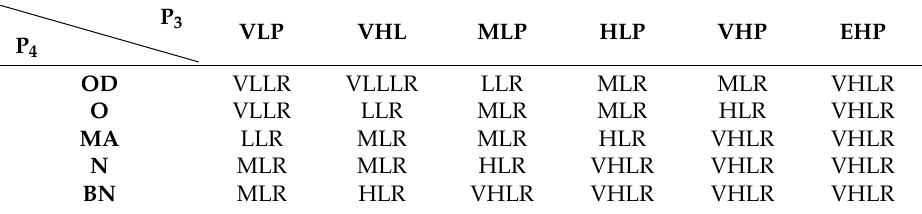
Table 3. Rule design for FIS_2.